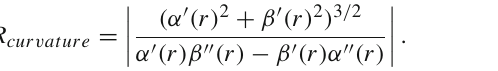
left. This is consistent with the discussion that we have given in the previous section. The impact parameters used in